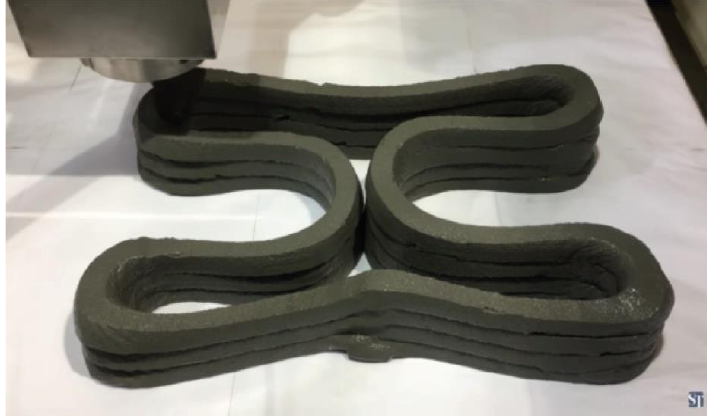
Figure 6. High temperature and recycled 3D thermoset polymeric